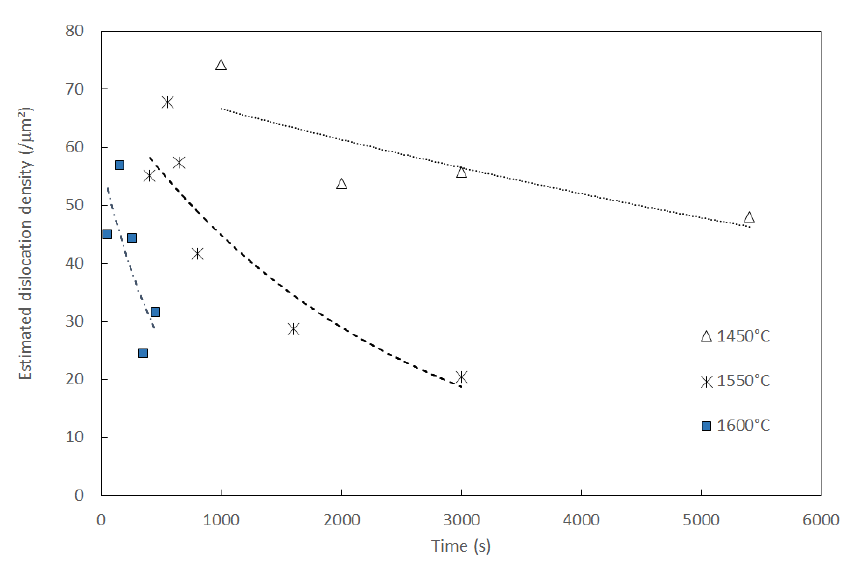
Figure 9. Estimated dislocation density computed from mean hardness versus time at different annealing